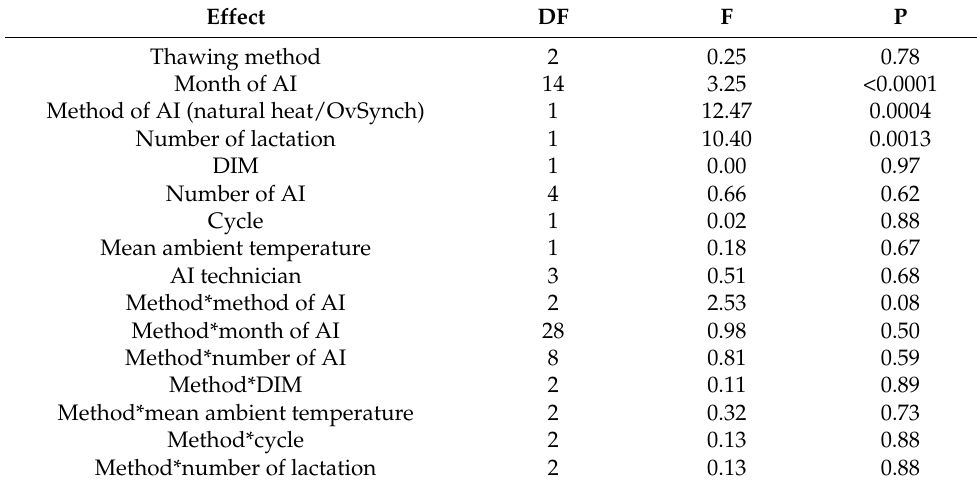
Table 6. Results of the second step of the GLMM with the inclusion of the random effect.